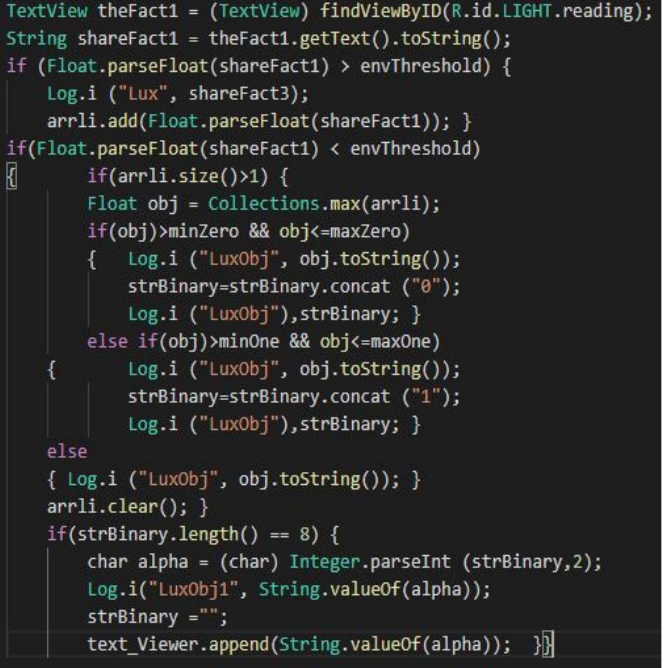
Figure 13. The structure of events for extracting binary characteristics from light intensity.